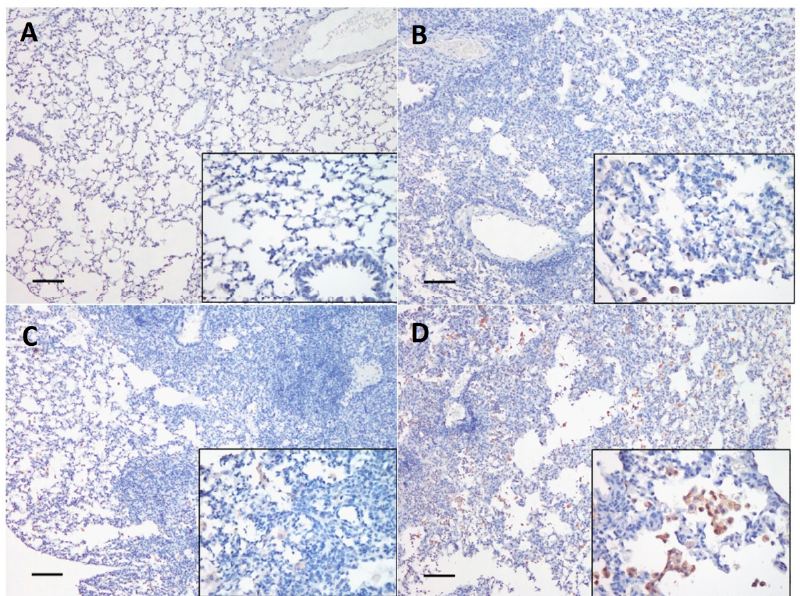
Figure 8. H6N1 viral antigen detection in mouse lung tissue at 15 d.p.i. using IHC staining. The mice were inoculated with PBS ( A ), 10 4 TCID 50 / mL of E01EE ( B ), 10 4 TCID 50 / mL of E01GK ( C ) and 10 6 TCID 50 / mL of E01GK ( D ). The scale bar is 100 µ m for the left 100 × magnification field. The right down corner is 400 × magnification field.